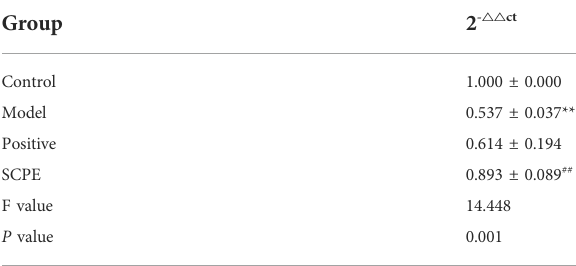
TABLE 8 Protein expression of P-co fi lin/co fi lin and F-actin/G-actin in mouse hippocampus (mean ± SD, n = 3).